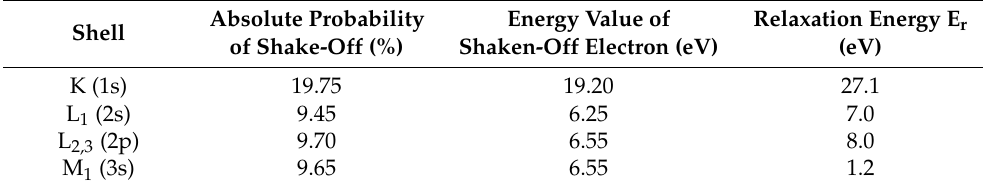
Table 1. The shell in which a vacancy caused a shake, the absolute probability of a shake occurring, the value of the shaken-off electron, and the relaxation energy associated with that shake-off. Absolute Probability Energy Value of Relaxation Energy E r Shell of Shake-Off (%) Shaken-Off Electron (eV) (eV) K